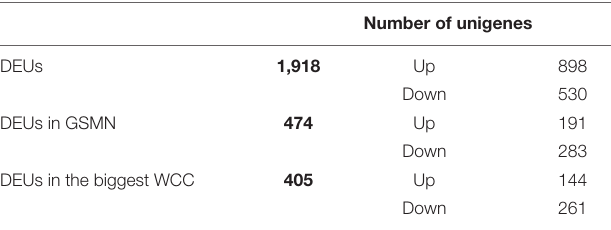
TABLE 6 | Results of differential genes expression